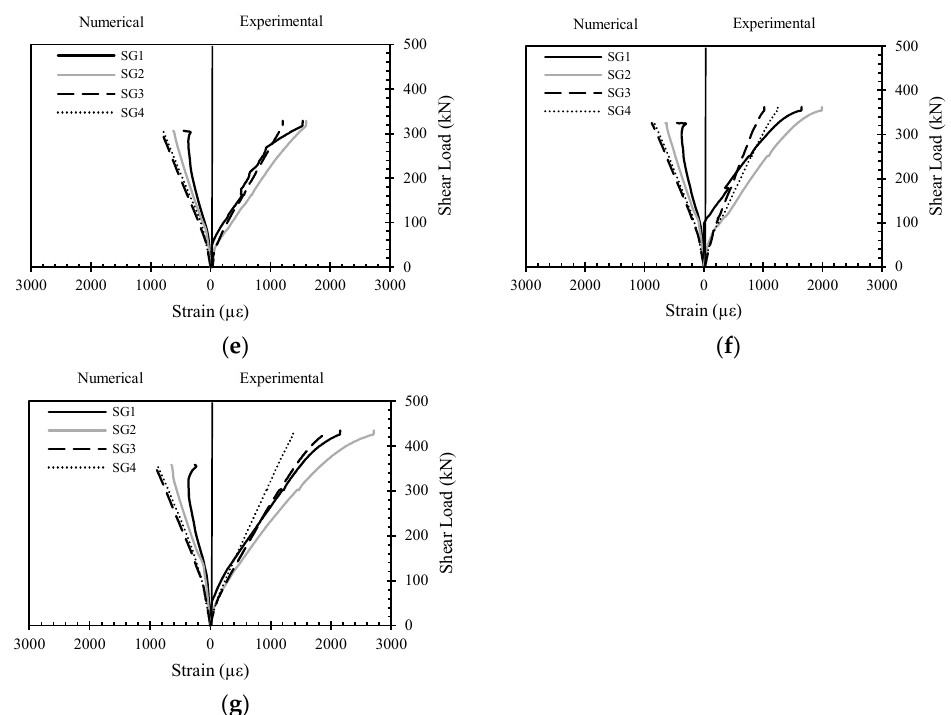
Figure 17. Numerical and experimental tensile steel strain responses: ( a ) NR0-SF0; ( b ) NR0-SF0-S; ( c ) NR100-SF0; ( d ) NR100-SF0-S; ( e ) NR100-SF1; ( f ) NR100-SF2; and ( g ) NR100-SF3.